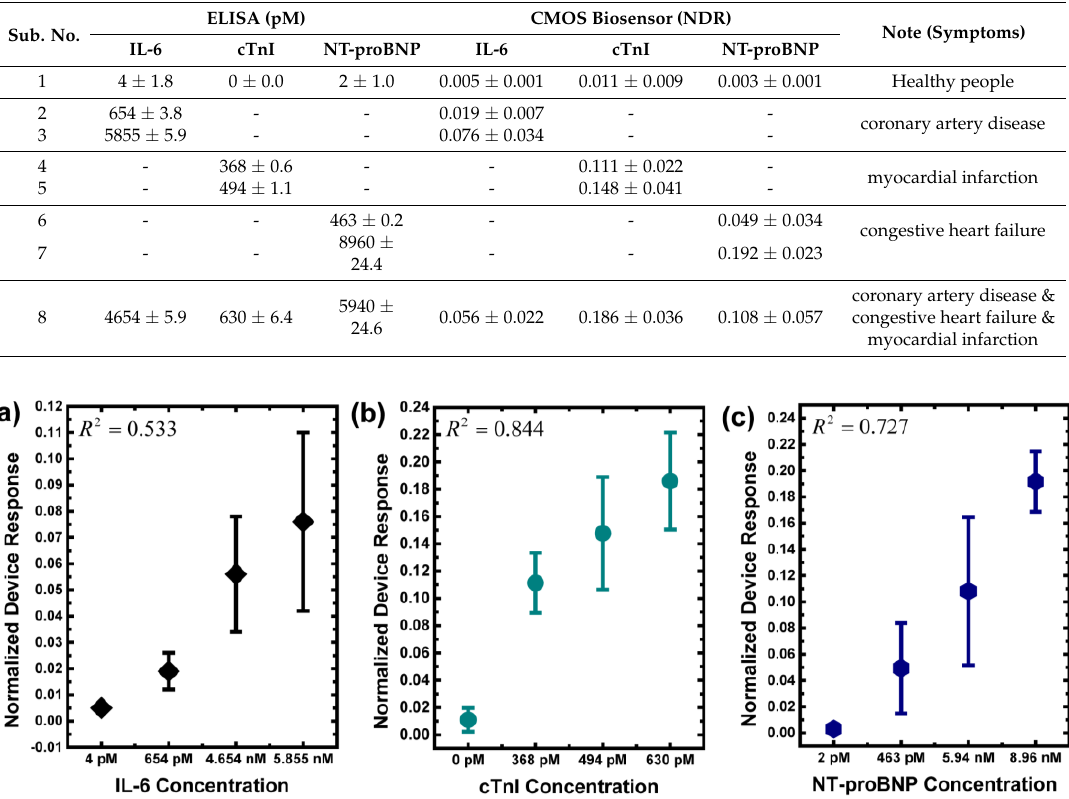
Figure 4. Experimental results of the three biomarkers in human serums. ( a ) IL-6; ( b ) cTnI; ( c ) NT-proBNP. In these plots, the x-axis represents the result measured by ELISA, and the y-axis represents the result measured by CMOS biosensors ( n = 3). It should be noted that, to make the plot directly comparable to the clinical-sample ELISA read-out, the x-axis is not to scale.